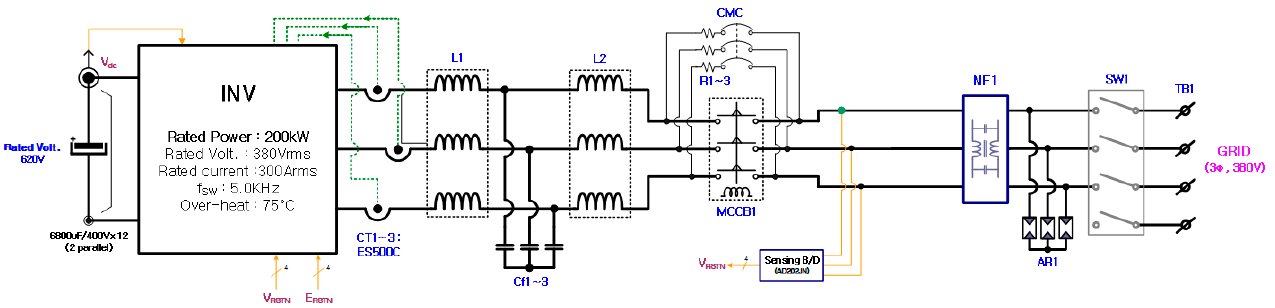
Figure 5. Block diagram of 200 kW inverter.